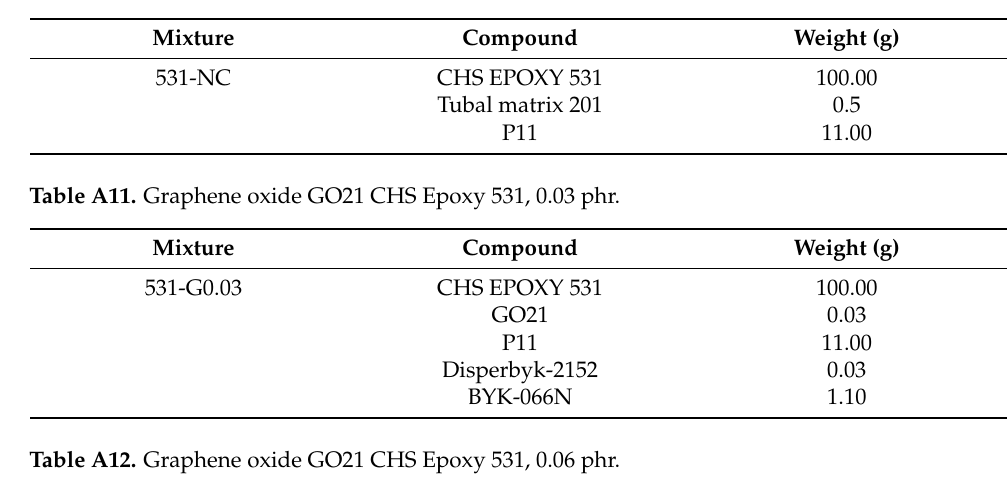
Table A10. Nanotubes in CHS Epoxy 531-NC [9].